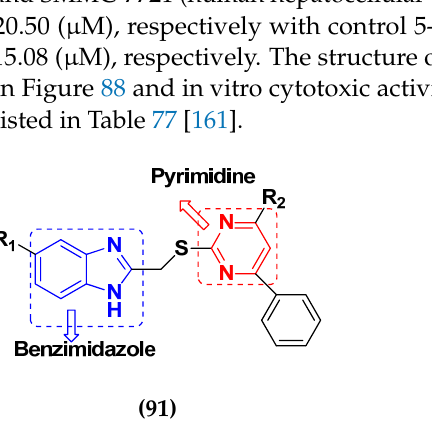
Figure 88. Structure of benzimidazole-pyrimidine derivatives ( 91 ). Table 77. In vitro cytotoxic activities of benzimidazole-pyrimidine hybrid compounds 91 ( a – c ). Compound